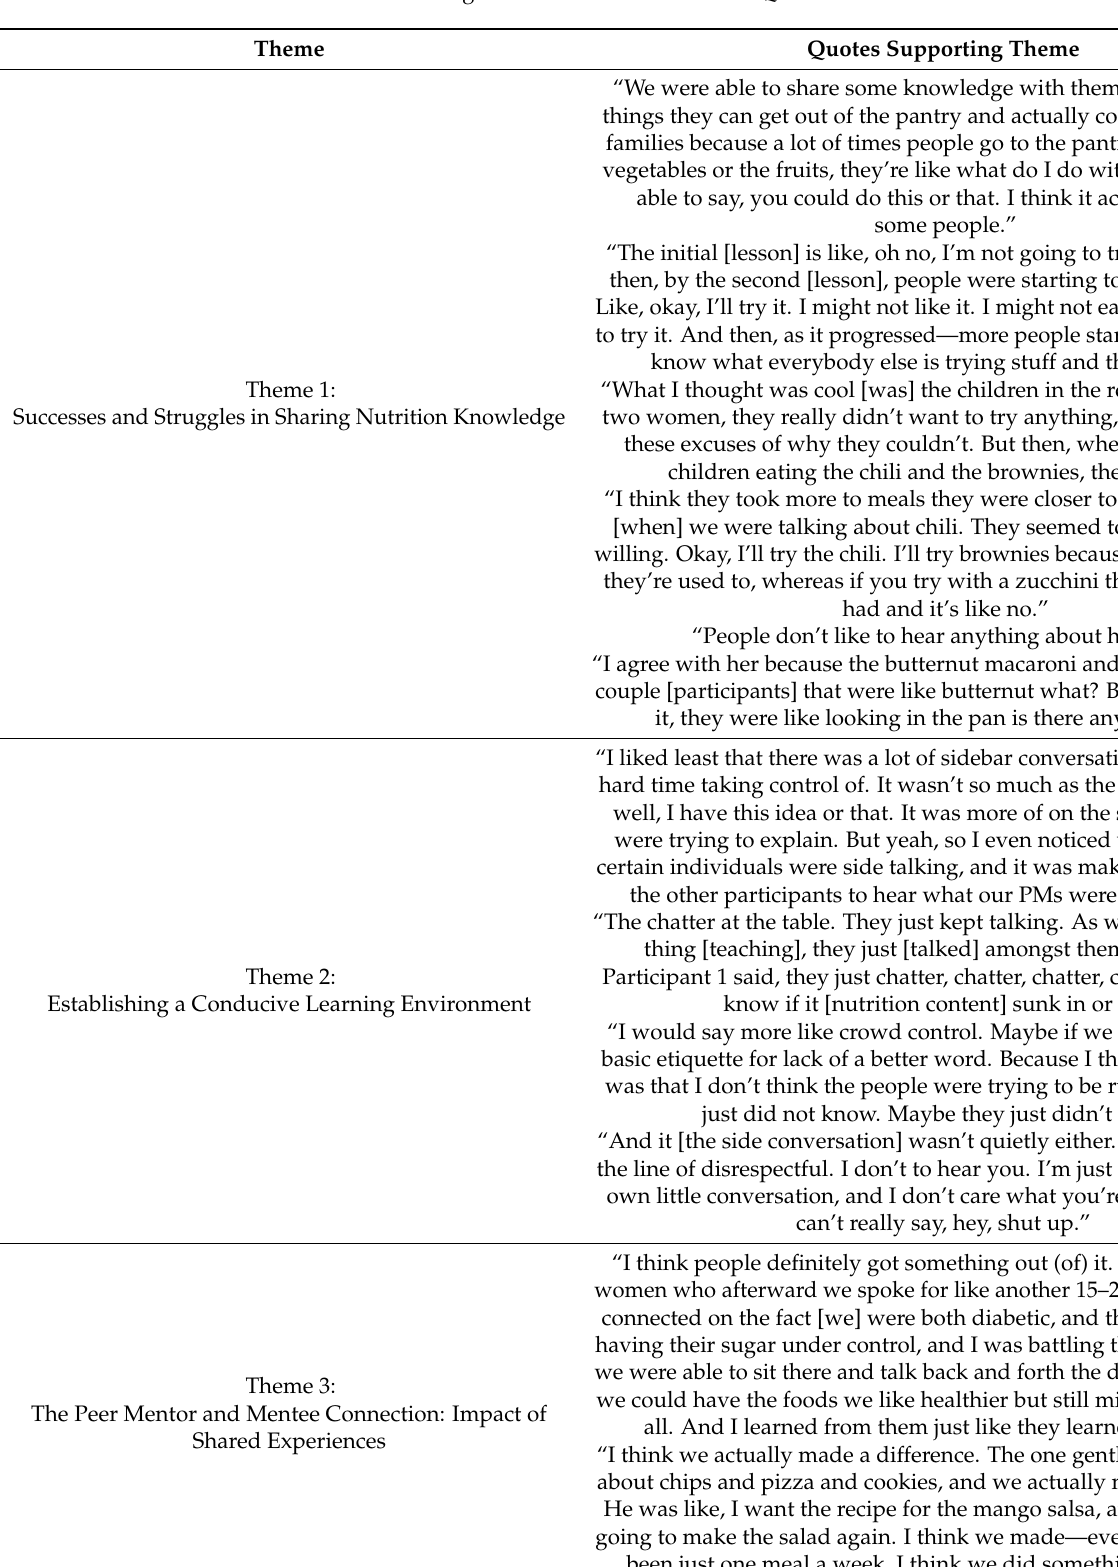
Table 1. Emergent Themes with Illustrative